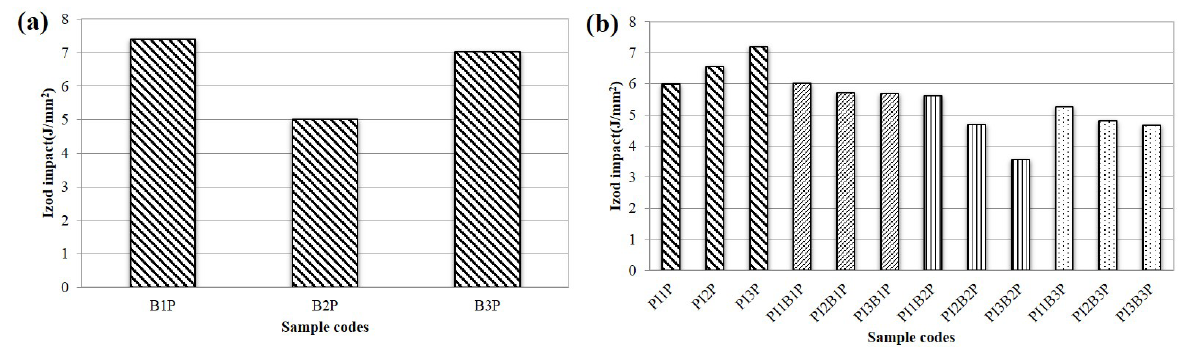
Figure 3: Izod impact values of composite materials a) boron/polyester composites, b) pine cone/boron polyester